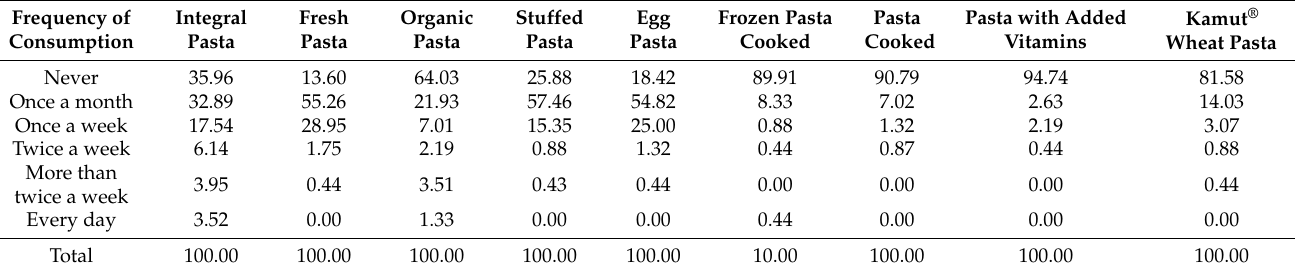
Table 3. Periodicity of the consumption of other pasta types.